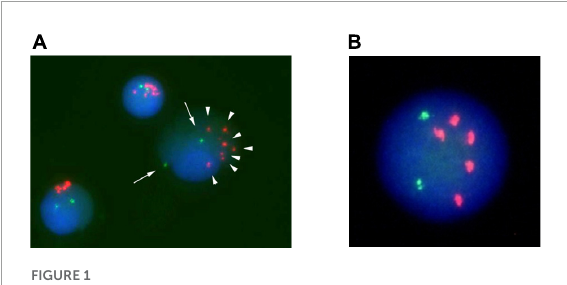
FIGURE1 Fluorescence in situ hybridization (FISH) analysis of Case 1 on interphase with an LSI ETV6/RUNX1 ES dual color probe. RUNX1 signals are in red, and ETV6 signals are green. (A) Cells at disease onset. (B) Cell at relapse.